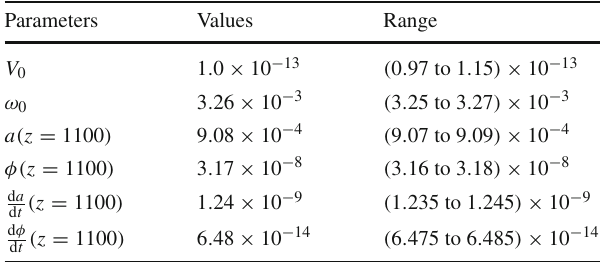
scalar field oscillates and decays via a gravitational effect